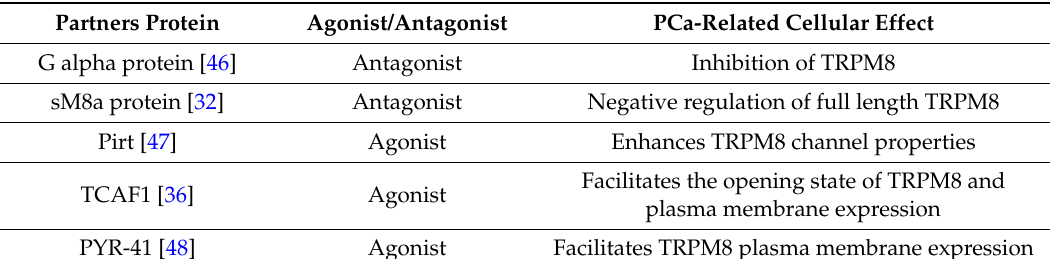
Table 2. TRPM8 regulatory proteins can be used in research therapies against